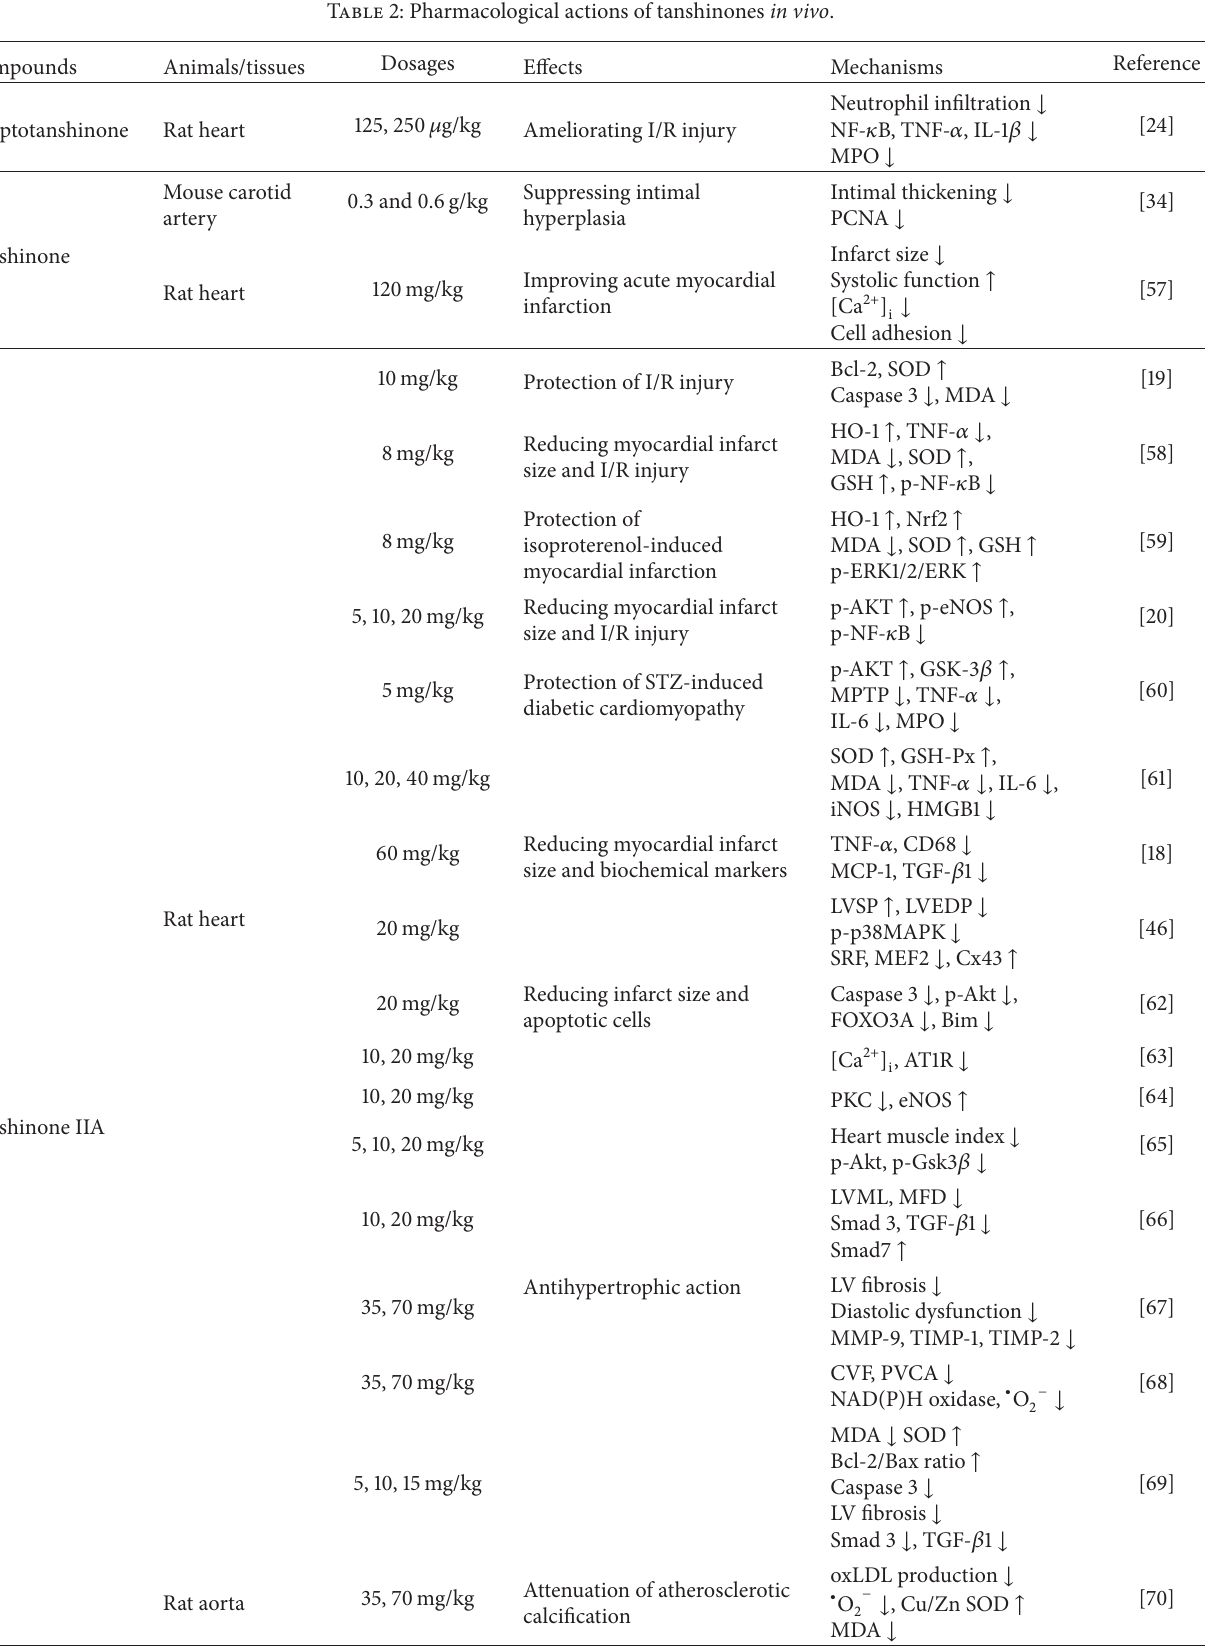
Table 2: Pharmacological actions of tanshinones in vivo